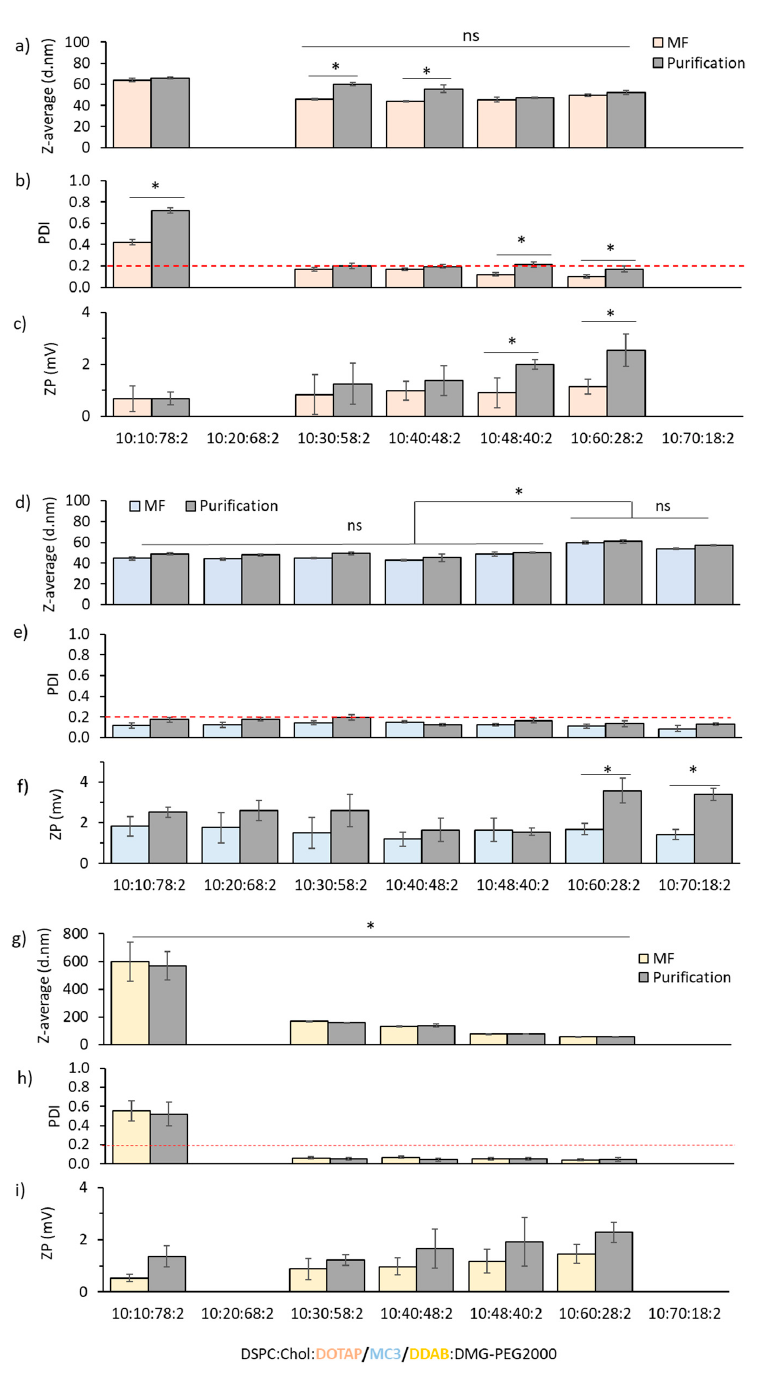
Figure 4. E ff ect of the molar ratio composition on DOTAP-cLNPs, MC3-iLNPs and DDAB-cLNPs. The molar ratio of DSPC and DMG-PEG2000 was kept constant at 10 and 2 mol% respectively; however, the ratio of cholesterol and the cationic lipid DDAB was varied from 10–60 and from 78–28 mol% respectively. ( a , d , g ) Particle size, ( b , e , h ) PDI and ( c , f , i ) zeta potential (ZP) of the DOTAP-cLNPs (pink), MC3-iLNPs (blue) and DDAB-cLNPs (yellow) after microfluidics and after purification via dialysis (grey). Results represent the mean of at least 3 independent batches and the standard deviation is plotted as error bars. Significant di ff erences are shown as * p < 0.05 and ‘ns’, when no statistical significance